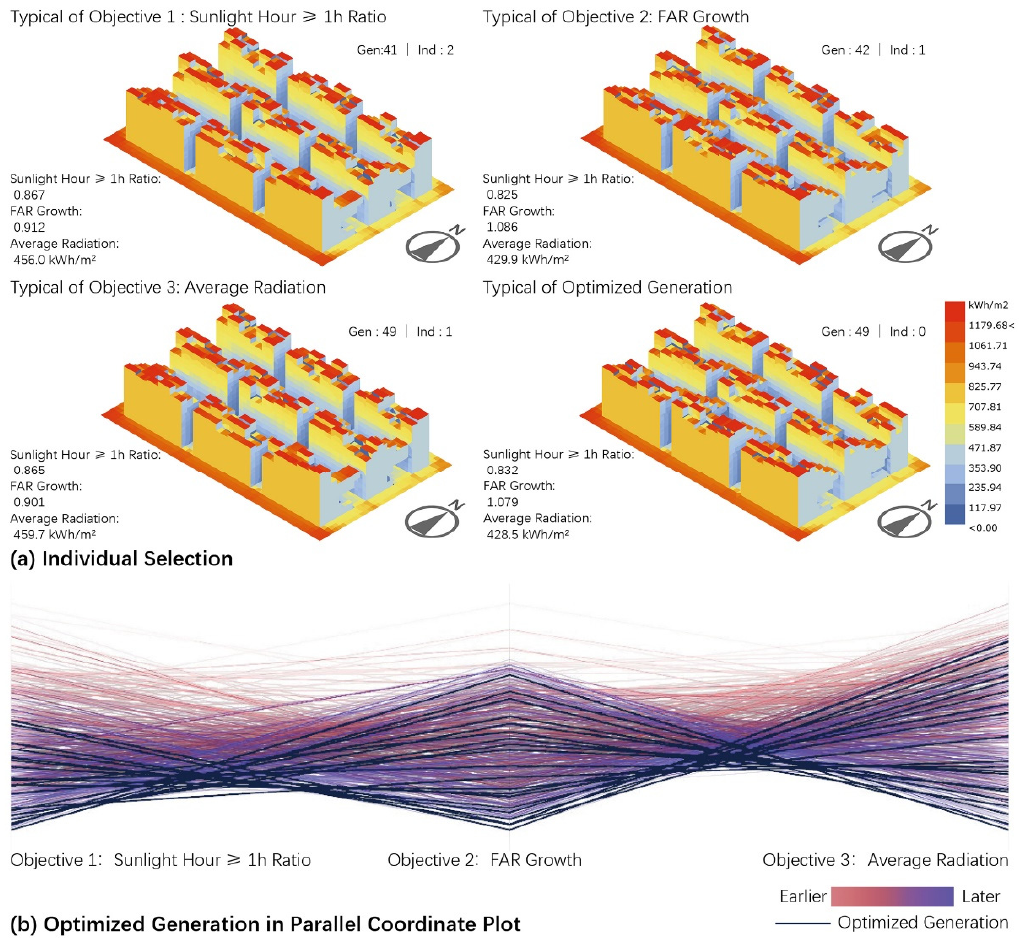
Figure 9. Selected solutions of the mixed addition mode.